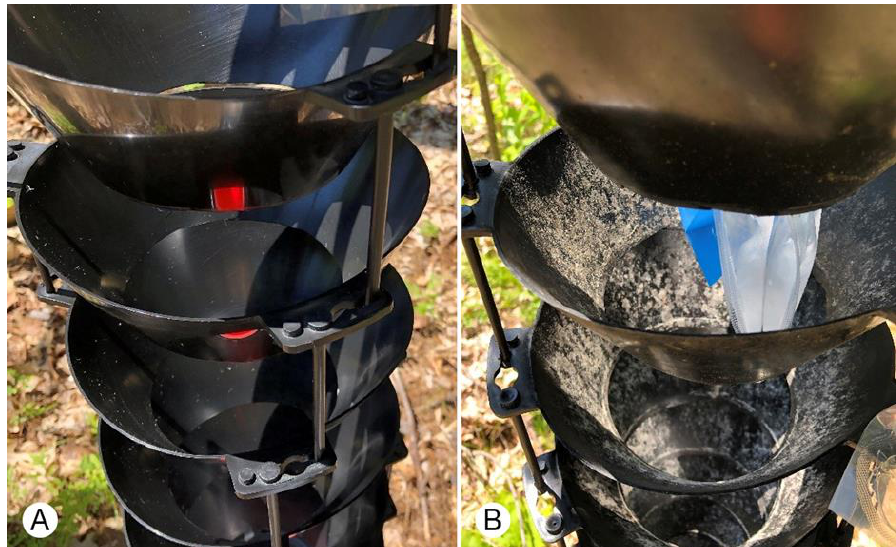
Figure 2. Example of modified multiple-funnel trap treatments from Experiment 2 after six weeks in a mixed hardwood-pine stand in southern Maine. ( A ) Trap cleaned with baby wipes during biweekly collections. ( B ) Control trap that was clean at the beginning of the season and then never maintained.